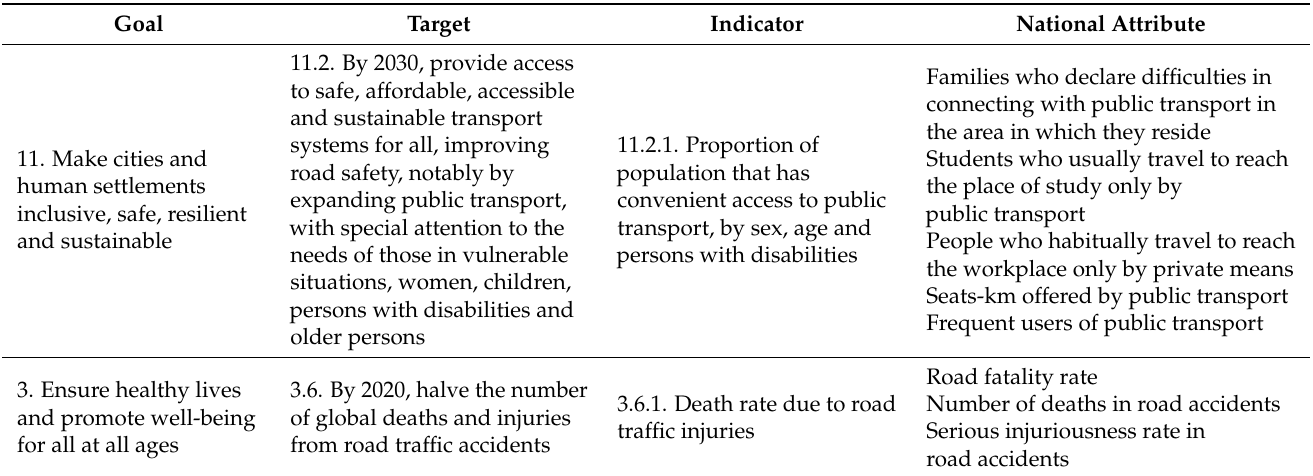
Table 1. Agenda 2030 direct indicators to